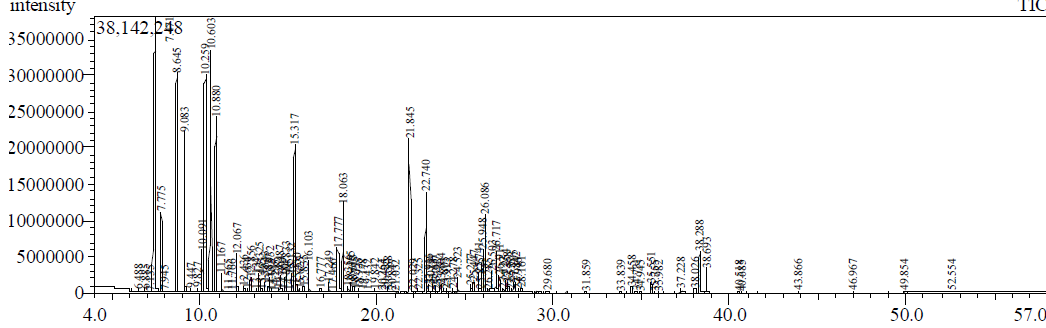
Figure 1. GC chromatogram of essential oil isolated from Syzigium cumini leaves grown in Egypt. Table 1. Chemical composition (%) of essential oil identified from Syzigium cumini leaves grown in Egypt using GC/MS analysis.